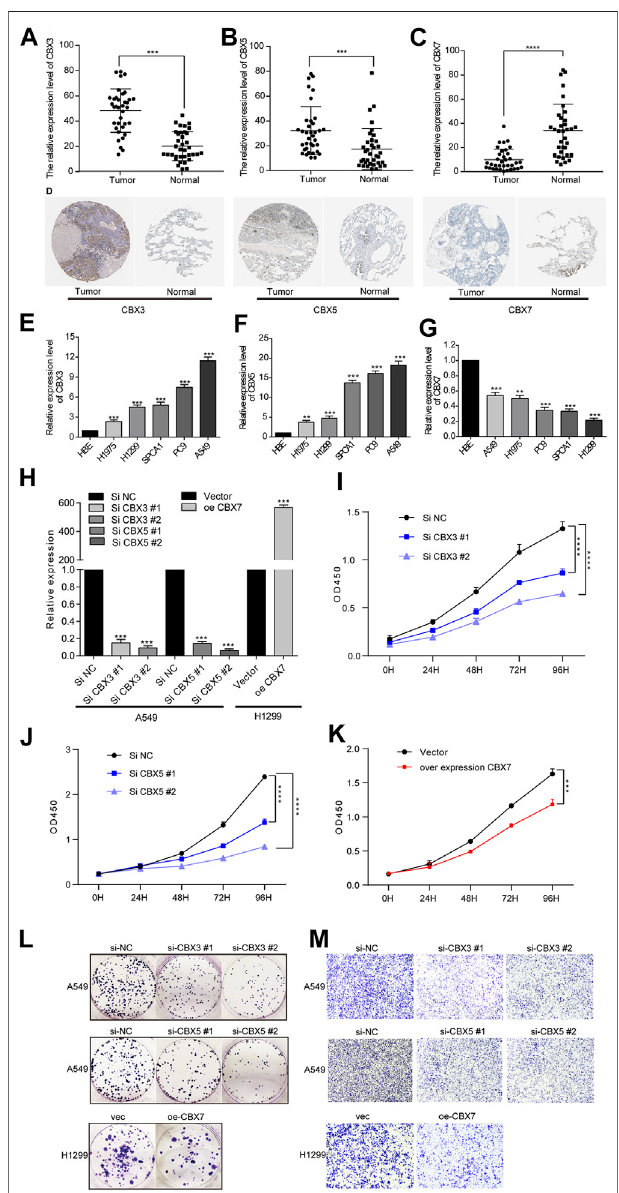
FIGURE8| Opposing expression trends and biologicaleffects ofCBX3/ 5 and CBX7 in LUAD tissues or cultured cells. (A – C) Opposing expression trends of CBX3/5 and CBX7 in LUAD tissues compared with normal tissues using qPCR analysis. (D) Representative picture of CBX3/5/7 protein expression trend (E – G) CBX3/5/7 expression in LUAD cell lines. (H) Veri fi cation of CBX3/5/7 overexpression and knockdown ef fi ciency in LUAD cell lines. (I – K) CCK-8 cell proliferation assay results from LUAD cells. (L and M) CloneformationandTranswellassayresultsfromLUADcells.NC:negative control. * p < 0.05, ** p < 0.01, and *** p <